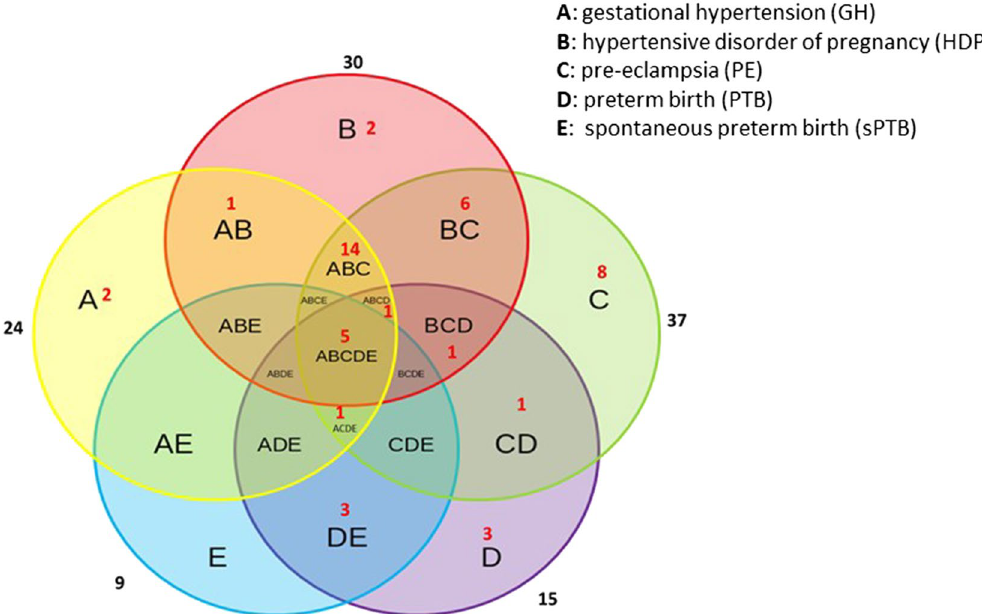
Figure 1. Overlap of pathways by complications under study. Venn diagram of metabolic pathways perturbed between cases (e.g., GH, HPD, PE, PTB, and sPTB) and controls. Pathway enrichment was conducted by Genego Metacore using Enrichment by Pathway Map, and the cut-off for pathway enrichment is p < 0.01. Each section of the diagram is labeled by capital letters (A, B, C, D, E), and the numbers of pathways that were specific to a certain phenotype (in the region with single capital letter) or overlapping between different phenotypes (in the region with combination of letters). The list of pathways corresponding to each section are shown in Table